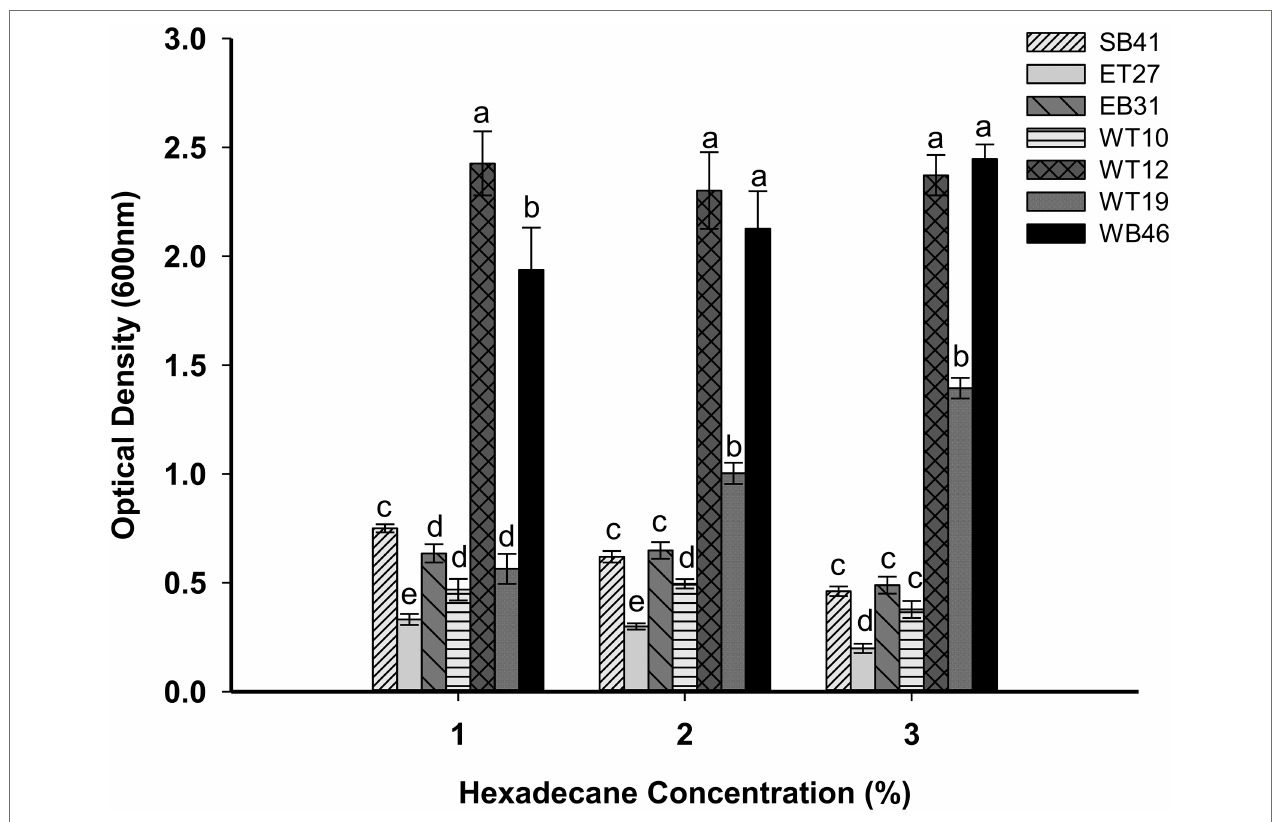
FIGURE 7 | Effect of different concentrations of n -hexadecane (1%, 2%, and 3%) on bacterial growth of selected bacterial strains. All strains were grown for 7 days. Error bars represent SDs, and different letters indicate significance according to Tukey’s post-hoc test at p ≤